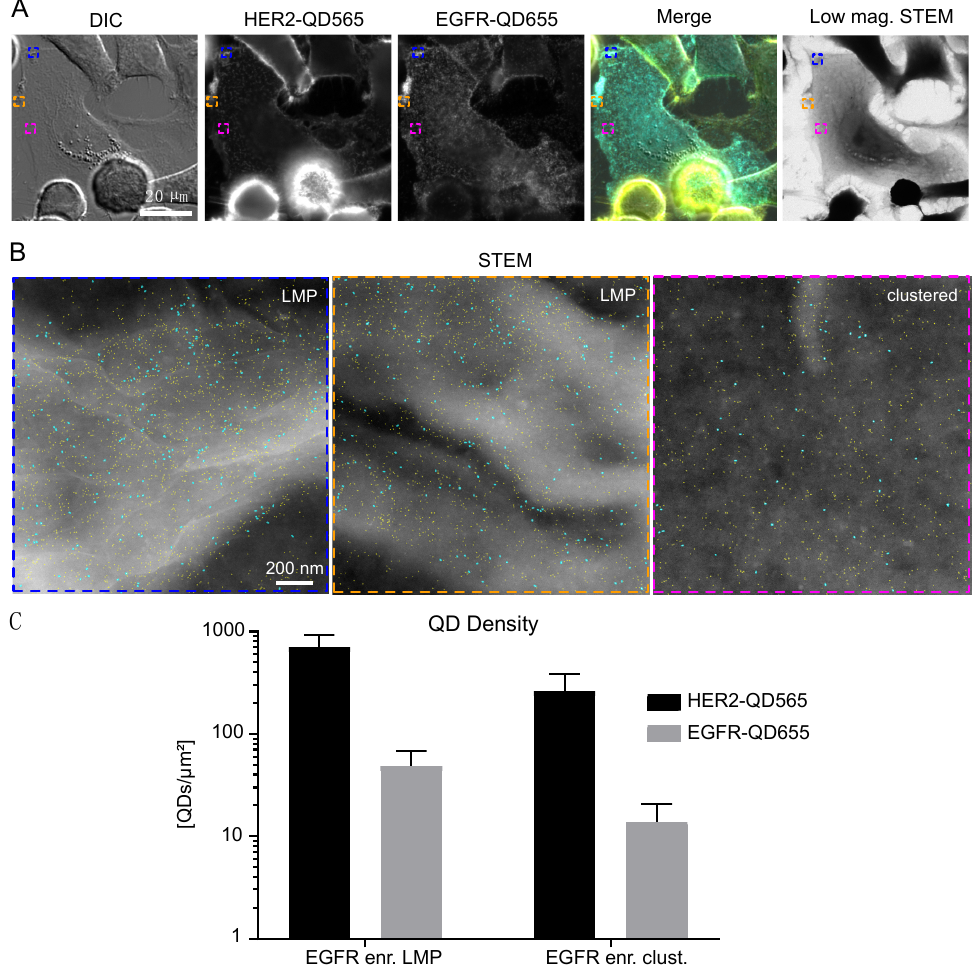
Figure 4. HER2 and EGFR expression on SKBR3 EGFR enriched cells. ( A ) Correlative fluorescence and low magnification electron microscopy of SKBR3 cells labeled for HER2-QD565 and EGFR-QD655. Light microscope images were taken with a 63× oil objective. The same region is shown for the low magnification brightfield STEM image, M = 800×. Colored rectangles depicted in ( A ) indicate the magnified areas shown in ( B ) acquired with annular dark field STEM at M = 120,000×. Individual QDs are visible and outlined in cyan (EGFR labeled with streptQD655) and yellow (HER2 labeled with streptQD565). ( C ) Mean QD densities for HER2 and EGFR for all analyzed EGFR enriched regions (large membrane protrusions and clustered) with standard deviation indicated. Colors in the merged image in ( A ): yellow for HER2 and cyan for EGFR. Scale bars: 20 µ m ( A ) and 200 nm ( B